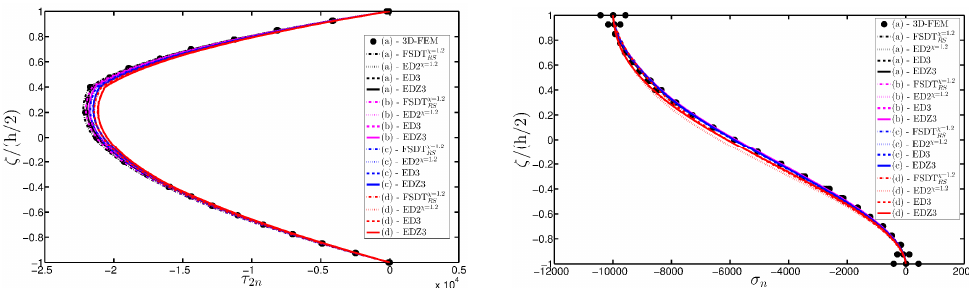
Figure 18. Through-the-thickness profiles of stress components [Pa] for the CCCC laminated square plate with   45 / 0 / 45 